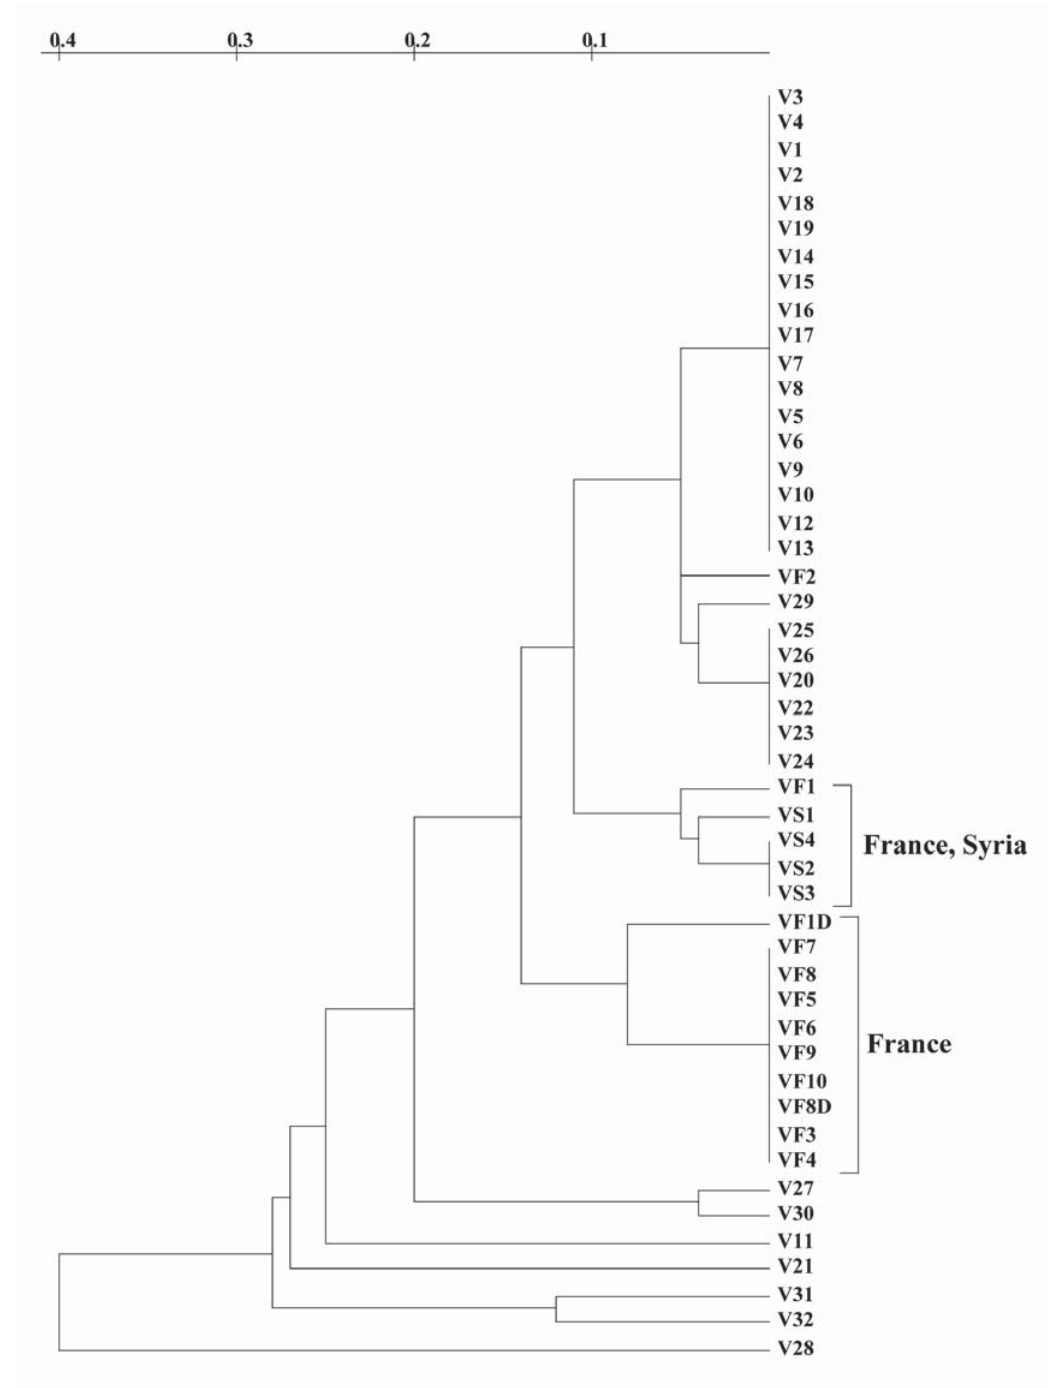
Fig. 3. Dendrogram showing the genetic relationships among the 43 Verticillium dahliae isolates. Cluster analysis was performed using the unweighted paired-group method with arithmetic averaging (UPGMA) and genetic dis- tances were obtained based on Simple Matching coefficient of 25 individual DNA bands produced by random ampli- fied polymorphic DNA